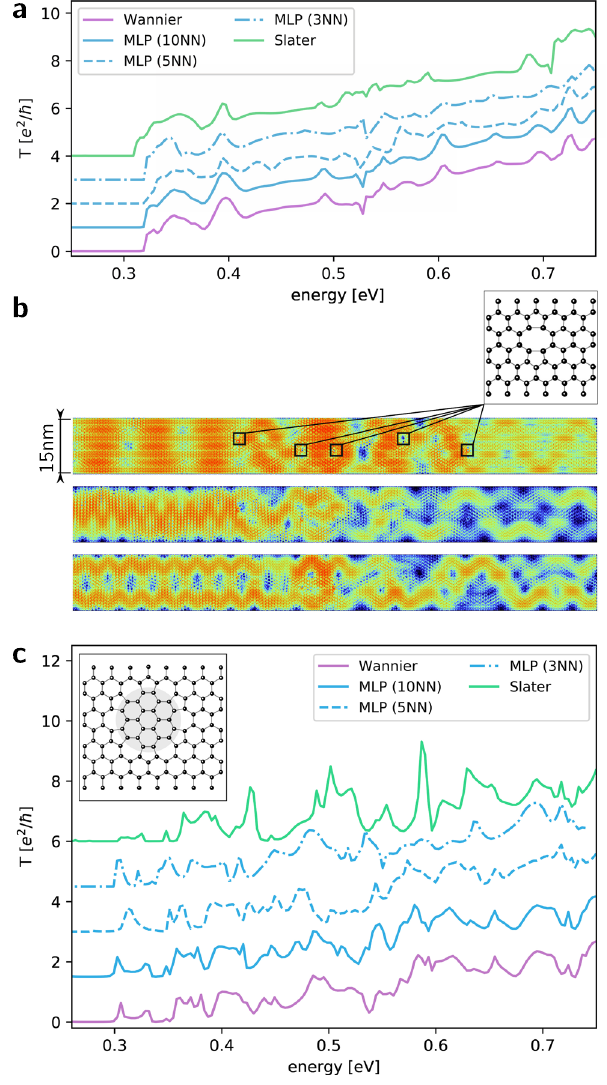
Fig. 7 Transport benchmark. Energy-dependent transmission T ( E ) for different TB parametrizations of the a double vacancy and c fl ower defect in SLG (vertically offset for clarity). b Scattering density plots for the three lowest modes at E = 0.7 eV in the double vacancy setup with ribbon-width and embedded defect positions indicated.